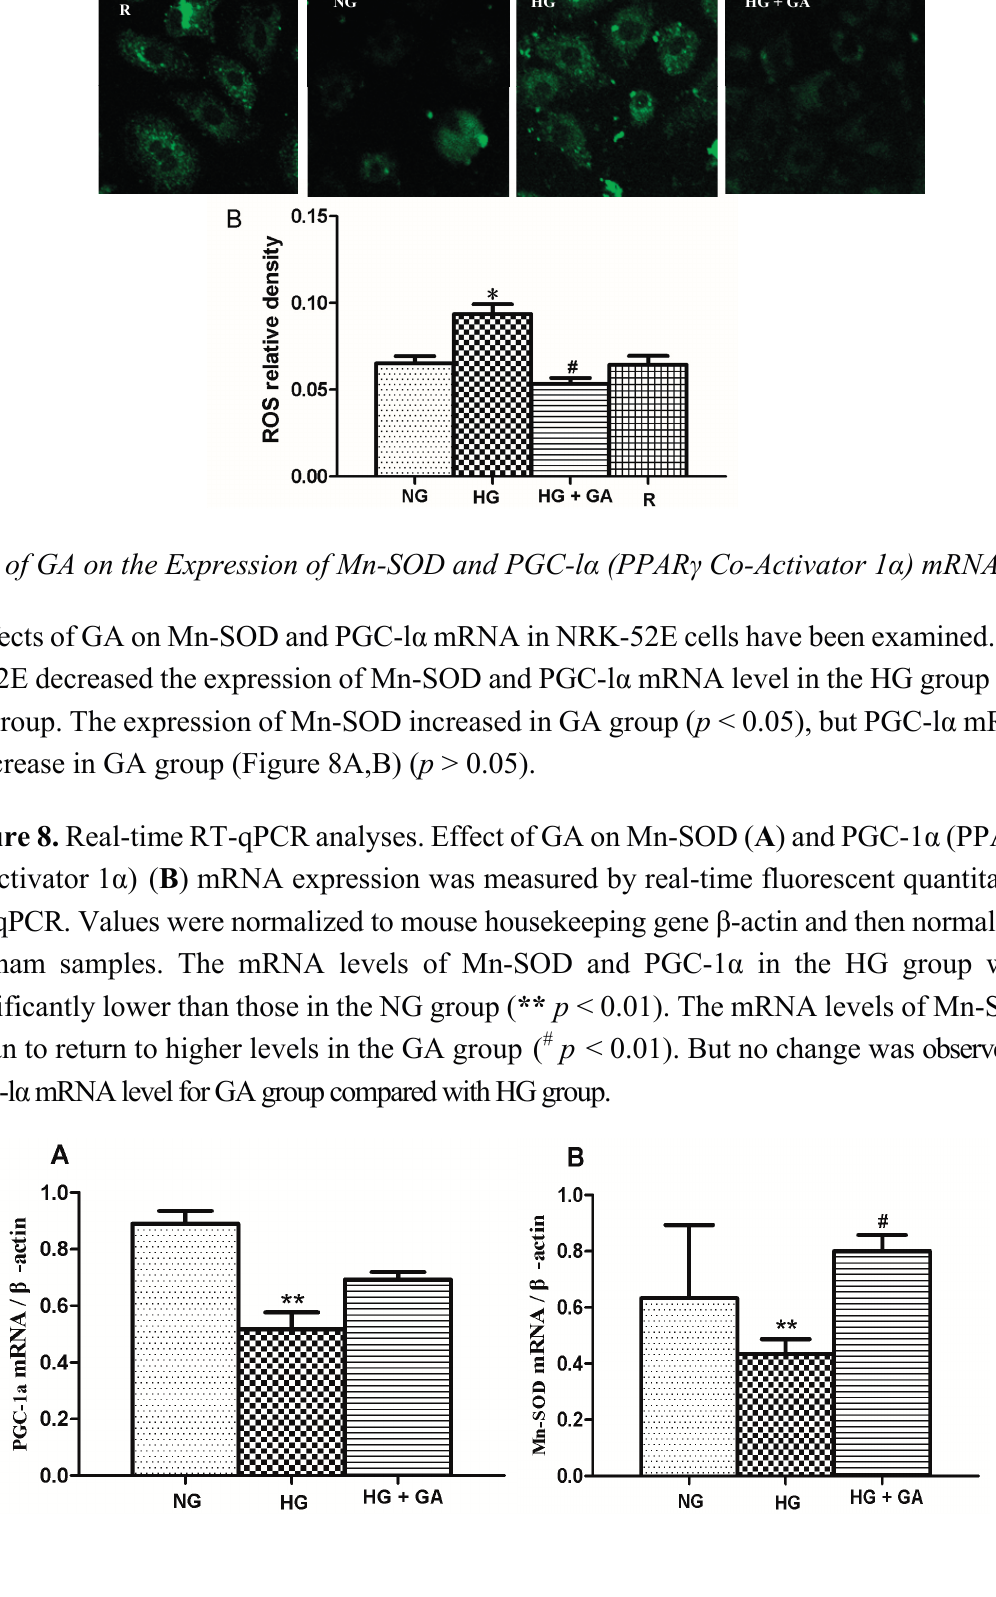
Figure 7. High glucose induces ROS (reactive oxygen species). Cells were grouped and treated for 24 h as indicated, followed by DCFH-DA (2',7'-dichlorofluorescin diacetate) (probe) or rosup (positive control) treatment for 30 min. Cell were then analyzed, using confocal microscopy. R represents rosup. ( A ) confocal microscopy images; ( B ) Histograms. * p < 0.05 vs. NG; # p < 0.05 vs. HG. A NG HG HG + GA R